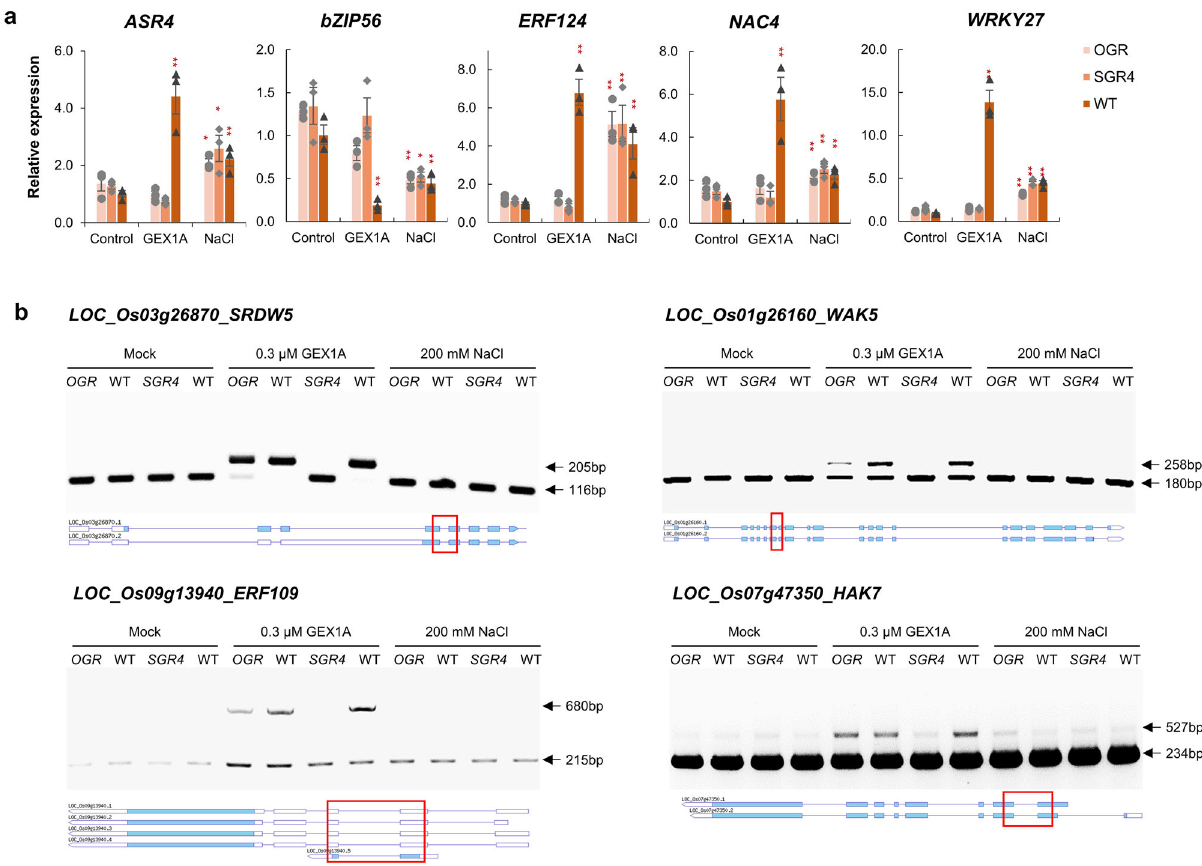
Fig. 8 Expression and splicing pattern analysis of stress-responsive genes after GEX1A and salt treatment in OGR and SGR4. One-week-old rice seedlings of OGR, SGR4, and WT are treated with mock, 0.3 μ M GEX1A, and 200 mM NaCl for 6-h. Total RNA extracted from the whole seedling was used for mRNA expression and splicing pattern analysis. a Expression of stress-responsive genes in OGR, SGR4, and WT. The GEX1A triggers the expression patterns similar to salt-stress treatment for all genes in WT but not in SGR4 and OGR. Bars represent the mean ± SEM of three replicates. OsActin was used as an internal control. (Student ’ s t -test; * P < 0.05, ** P < 0.01). b Semiquantitative RT-PCR analysis of alternative splicing patterns of stress-responsive genes in OGR, SGR4, and WT. No intron retention is observed in SGR4 under GEX1A treatment. Arrowheads indicate splicing variants that changed following GEX1A treatment. The gene structures and retained introns are shown. Red boxes indicate the PCR